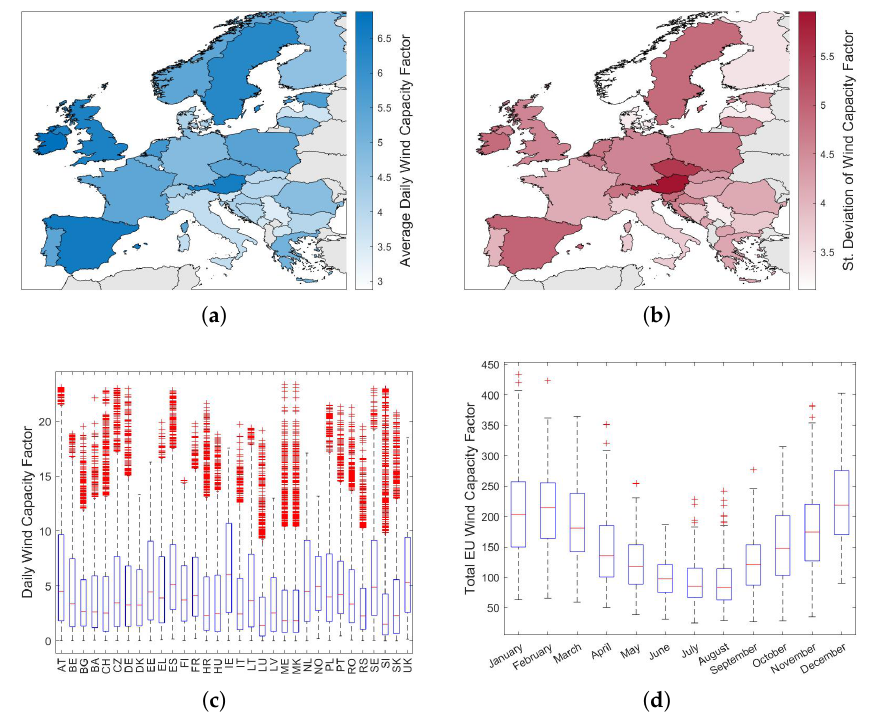
Figure 3. Statistical aspects of sample wind capacity factors: shown are the country average ( a ), standard deviation ( b ), unconditional distribution ( c ) and a seasonal analysis of the aggregate wind capacity factor ( d ).